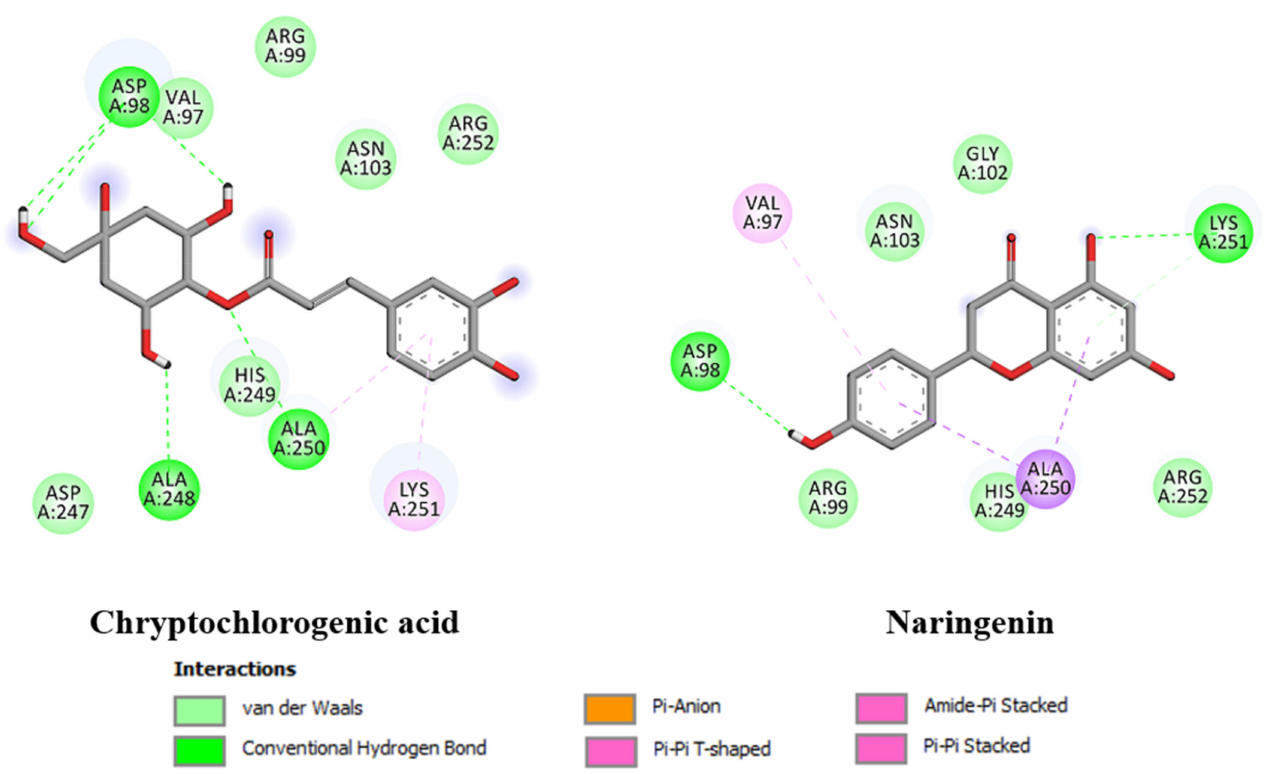
Figure 5. Non-bonding interactions of highest binding affinity against ZIKV envelope protein using docking calculations. The 3D structure of the complex formed between cryptochlorogenic acid and the active site of the target is shown in Figure 6. The surface of the active site is represented by the charge distribution of the amino acids at the active site. The red color represents the negative charge, while the blue color of the amino acids shows negative charge. As shown in Figure 6, cryptochlorogenic acid is trapped between two negatively charged amino acids, Ala248 and Asp98, where most of the hydrogen bonds are formed in the case of the envelope protein.